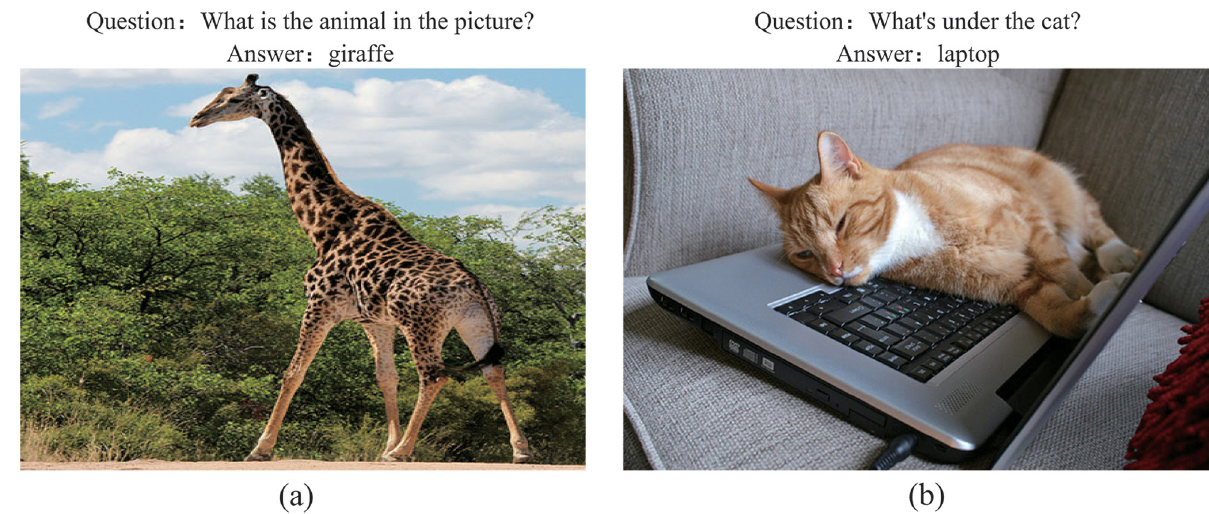
Fig 1. Example of visual question answering